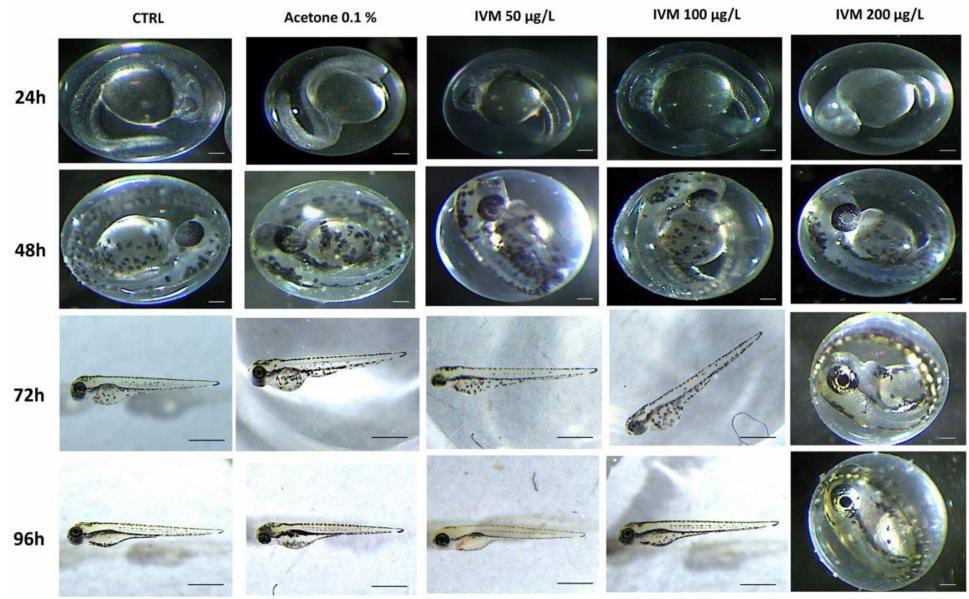
Figure 2. Optical micrographs control after incubation with IVM and acetone 0.1% for 96